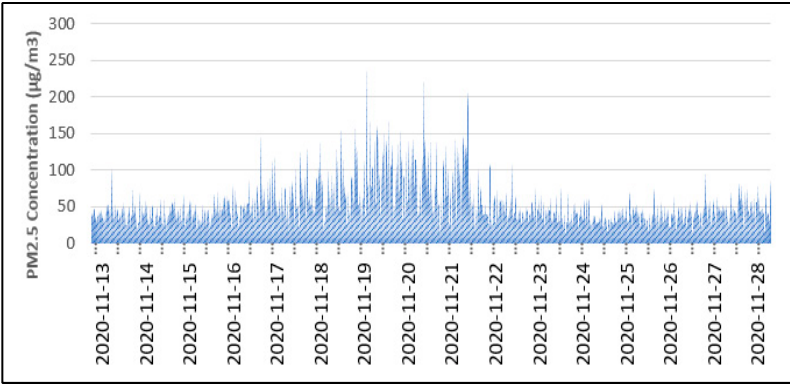
Figure 11. Temporal distribution of PM 2.5 during the testing.